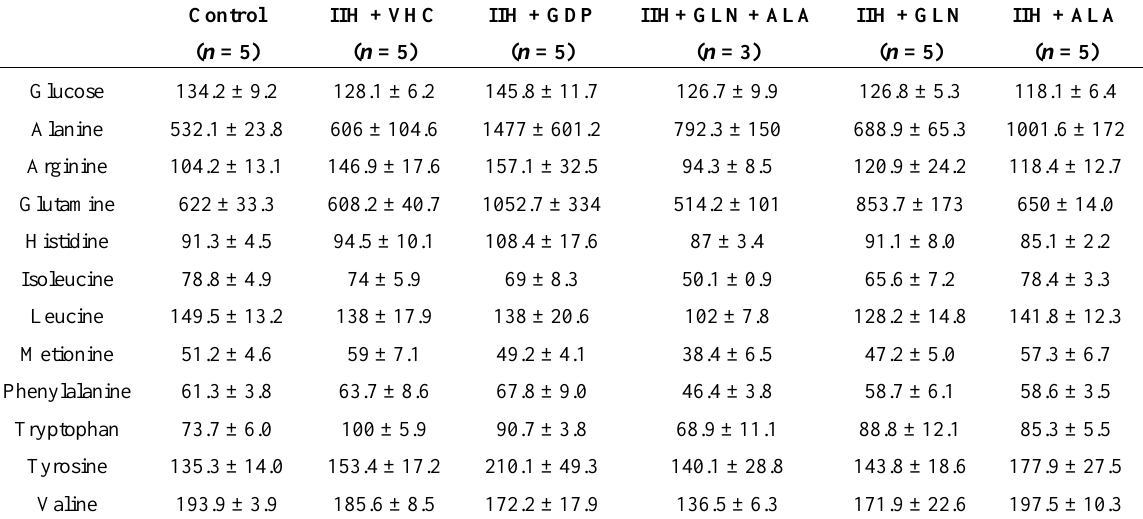
Table 4. Blood glucose (mg/dL) and amino acid (nmol/mL) levels 15 min after intraperitoneal insulin injection (IIH group). The IIH group was divided into 5 subgroups: IIH + oral vehicle (VHC), IIH + oral glutamine dipeptide (GDP), IIH + oral glutamine (GLN) + oral alanine (ALA), IIH + oral GLN or IIH + oral ALA. GDP (1000 mg/kg), GLN (619 mg/kg) + ALA (381 mg/kg), GLN (619 mg/kg), ALA (381 mg/kg), or VHC was administered. The